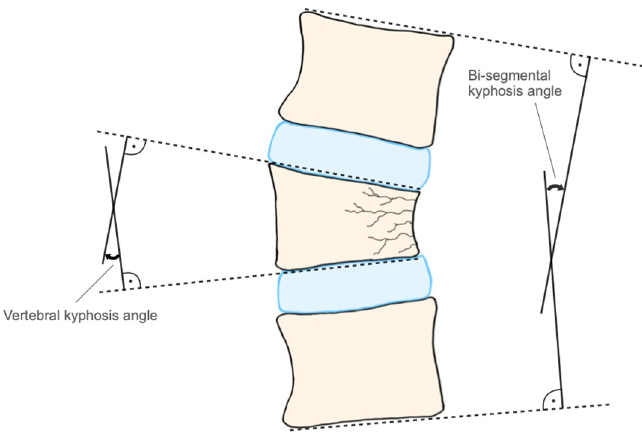
Figure 1. Vertebral and bi-segmental kyphosis angle. Statistical Analysis